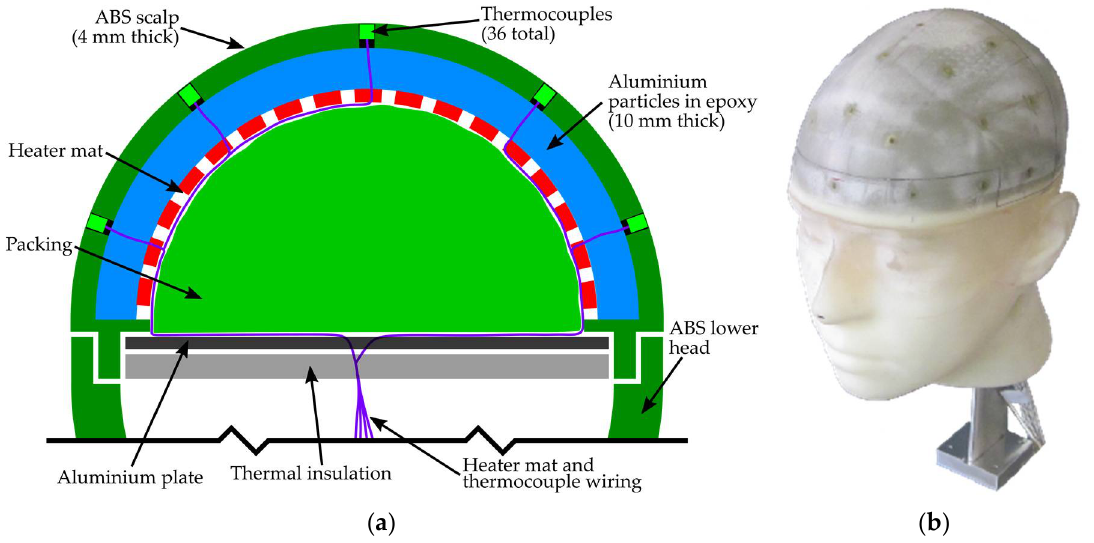
Figure 1. ( a ) Cross-sectional view of the heated headform detailing the construction. ( b ) Final fabricated headform, prior to being painted